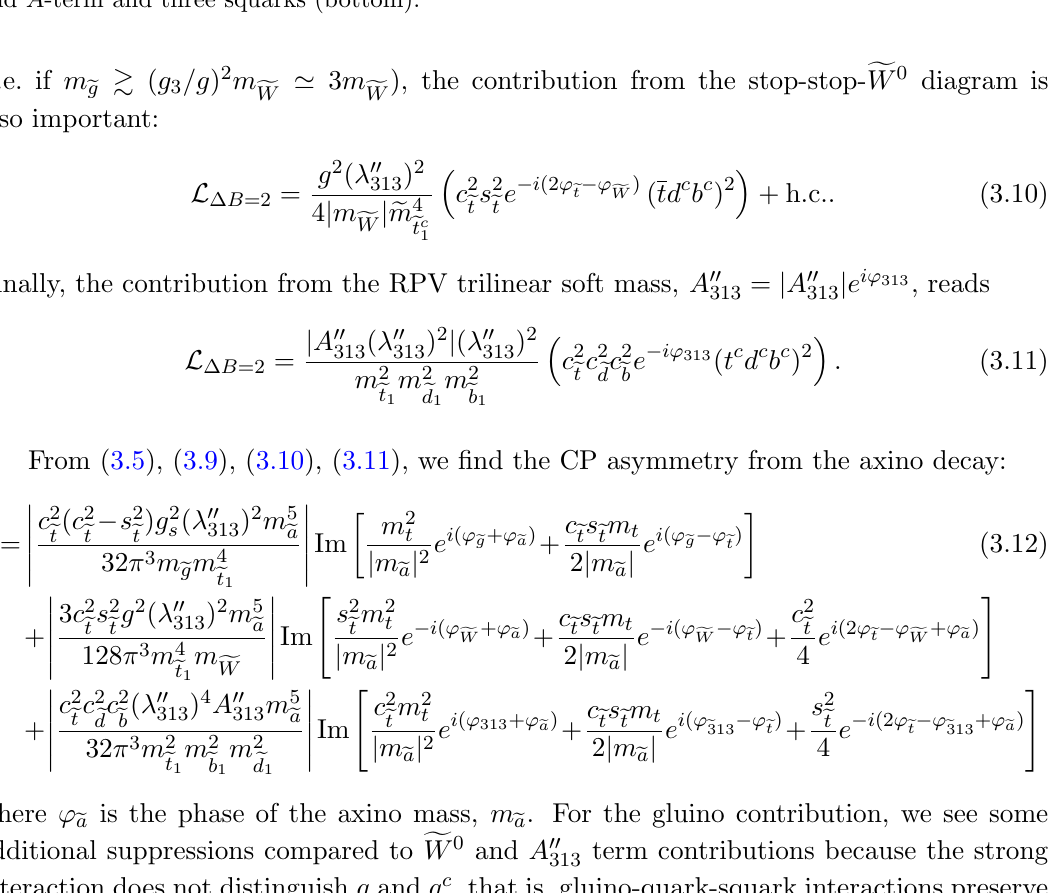
Figure 3 . The six quark baryon number violating interactions mediated by gaugino and stop (top), and A -term and three squarks